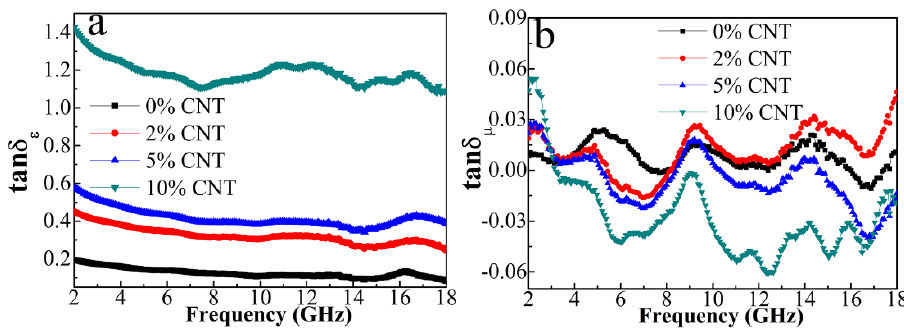
Figure 10. Frequency dependences of tan δ ε ( a ) and tan δ µ ( b ) of the four composites.